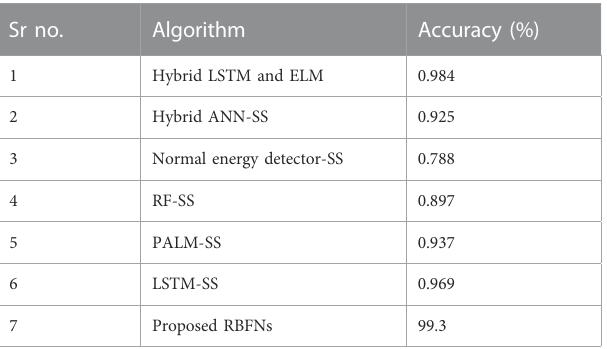
TABLE 2 Validation accuracy for the proposed algorithms. Sr no.